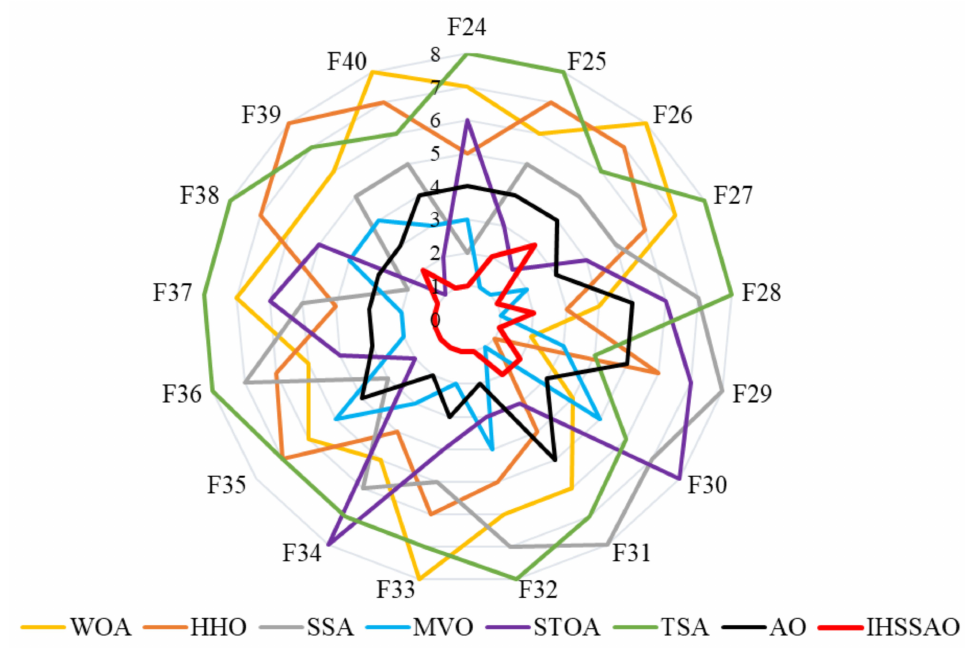
Figure 8. Radar ranking diagram of the nine algorithms on 17 CEC2017 functions. Table 10. Rankings of IHSSAO and other algorithms on 17 CEC2017 functions. F